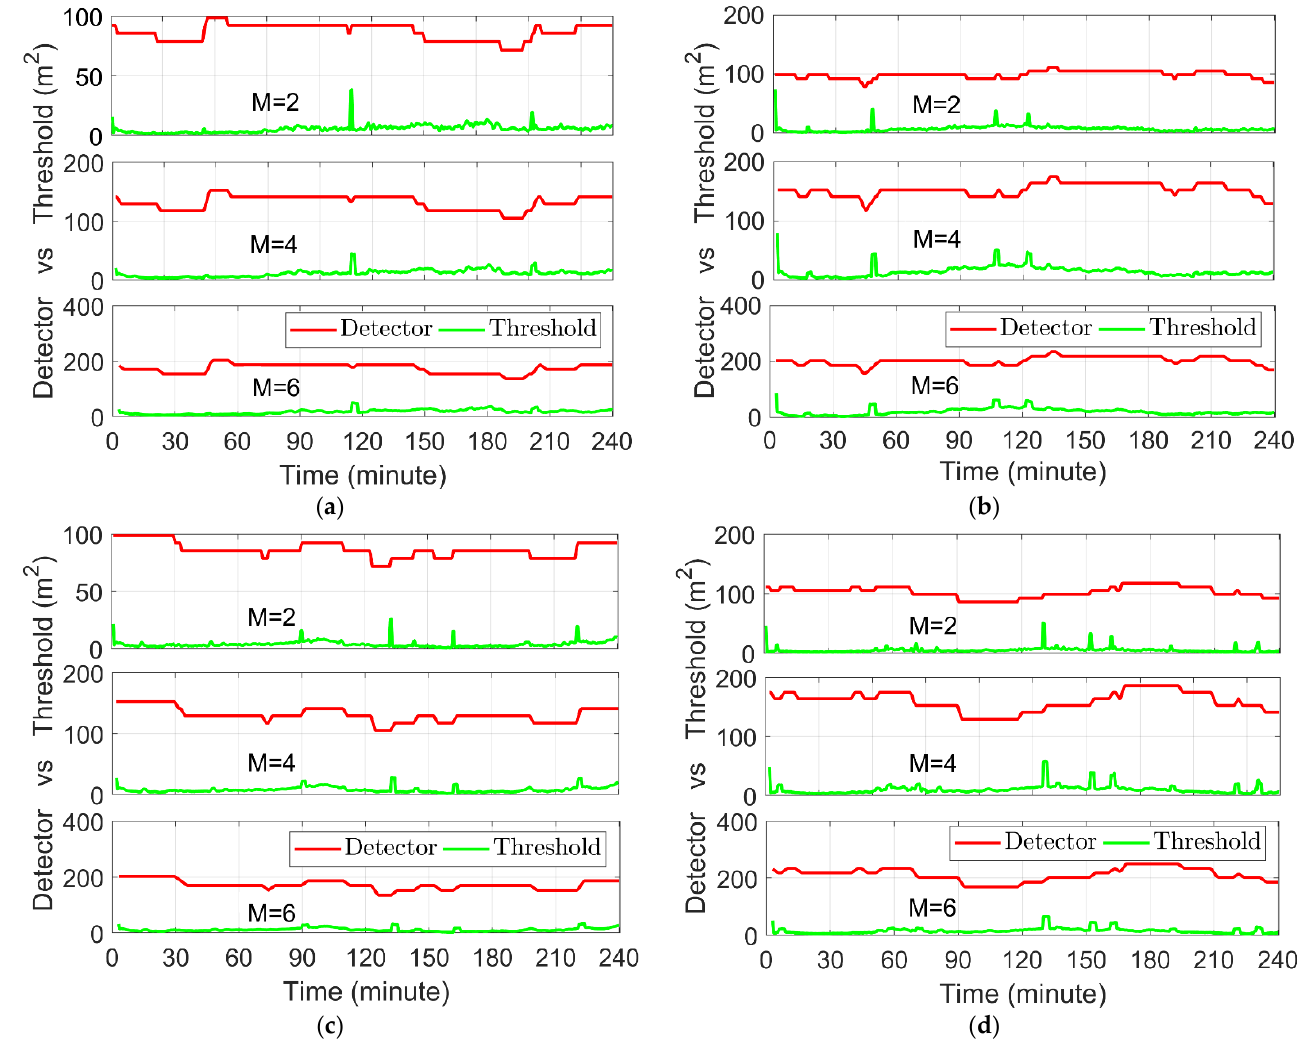
Figure 9. The three PEs, including the updated STDs and ALs of the: ( a ) BREW station; ( b ) FAIR station; ( c ) HUEG station; and ( d ) DAV1 station. The top, middle and bottom panels of each figure represent the east (E), north (N) and up (U) directions. The RMSs of the PEs after convergence are noted on the panel, respectively.